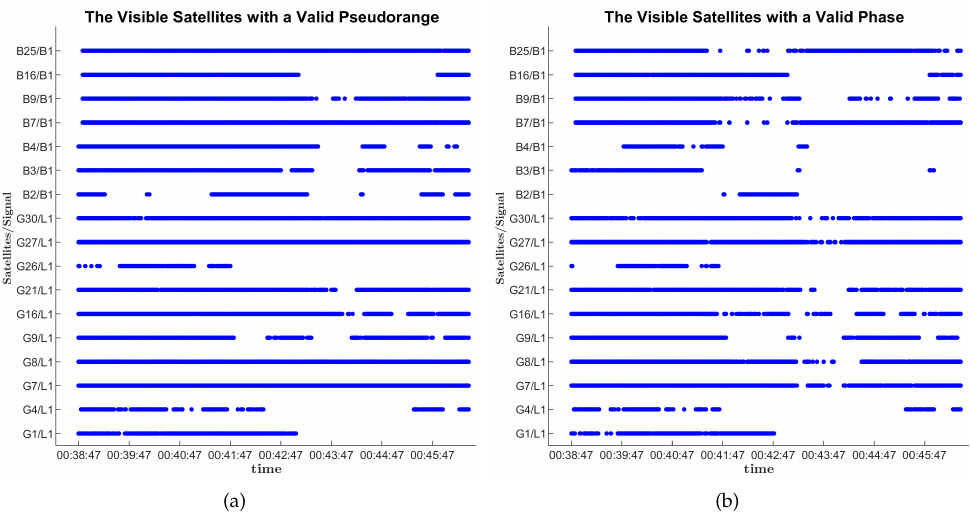
Figure 10. The visible satellites with a valid pseudo-range and the visible satellites with a valid carrier phase. ( a ) The visible satellites with a valid pseudo-range. ( b ) The visible satellites with a valid carrier